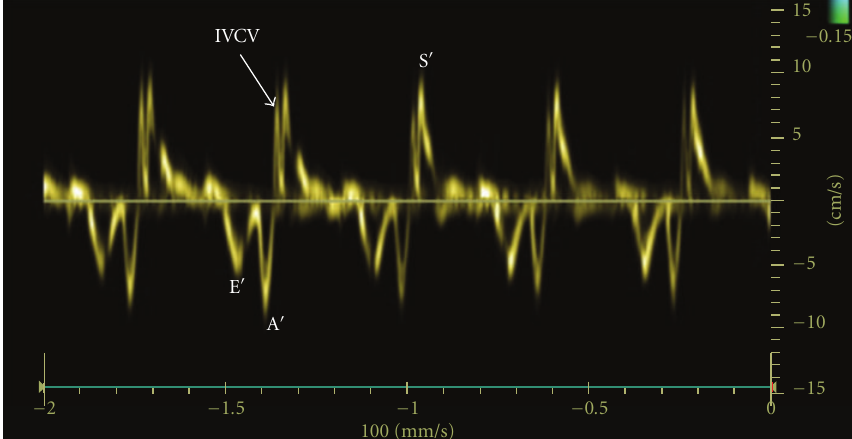
Figure 3: Tissue Doppler-derived left ventricular longitudinal myocardial velocities at the level of mitral valve annulus during angiotensin II infusion demonstrating absence of myocardial isovolumic relaxation velocity